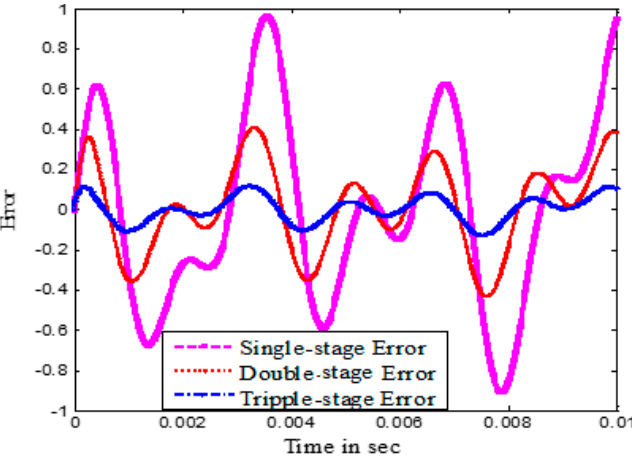
Figure 16. Error Figure 16. Error signal.